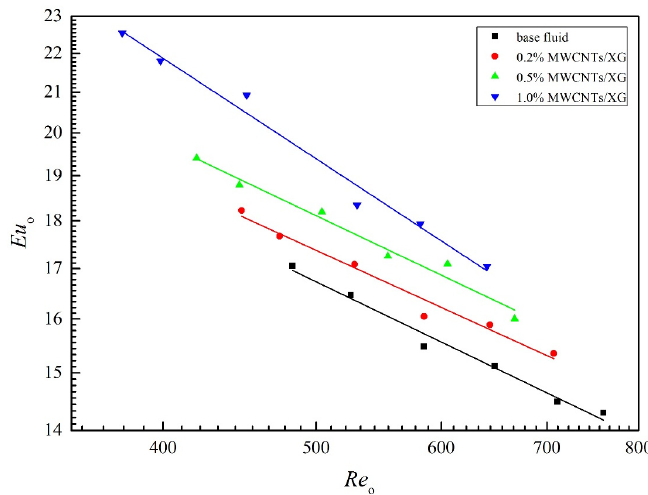
Figure 12. Euler number versus Reynolds number.